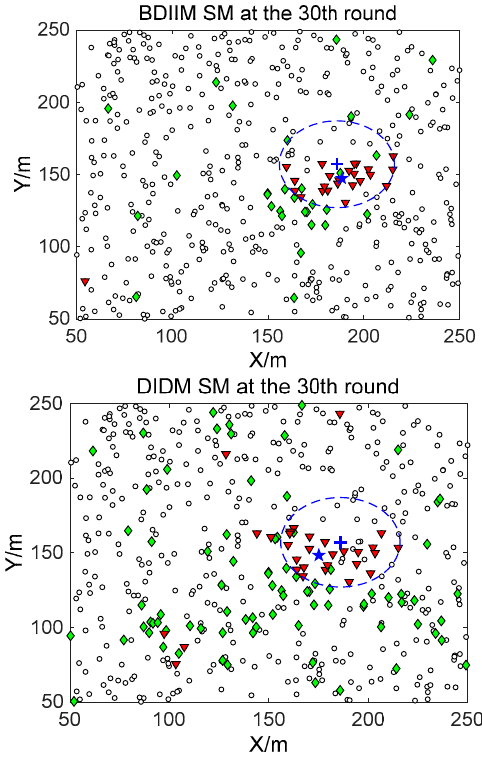
Figure 7. The state of the SM at the 30th time interval.